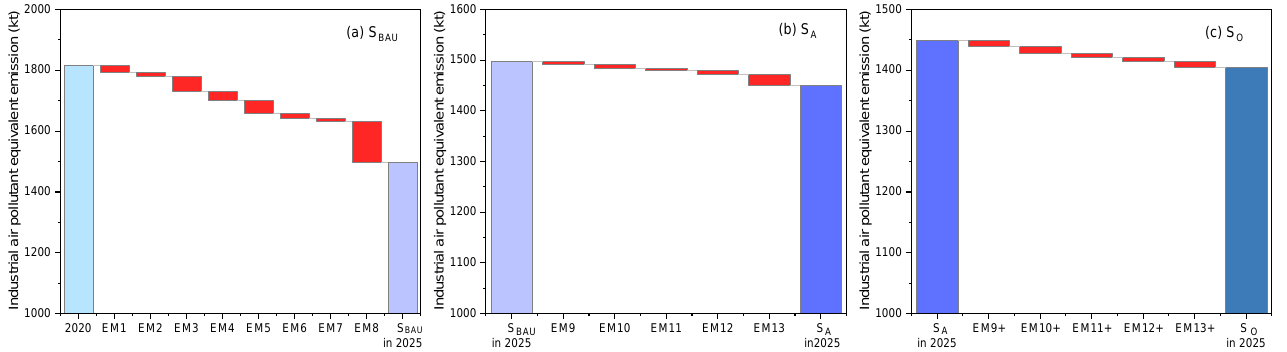
Figure 5. Industrial air pollutant emission reduction benefits in 2025: ( a ) Emission reductions from eight measures in S BAU ; ( b ) Emission reductions from five additional measures in S A compared to S BAU ; ( c ) Emission reduction from five enhanced measures in S O compared to S A .